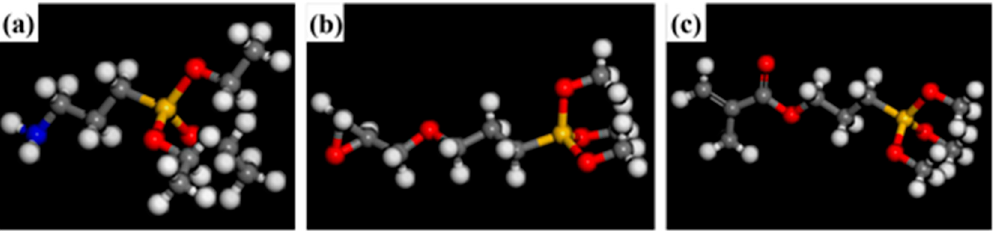
Figure 2. Molecular model of modifiers: ( a ). KH550, ( b ). KH560, ( c ). KH570 (Gray represents C atom, yellow represents Si atom, white represents H atom, red represents O atom and blue represents N atom).